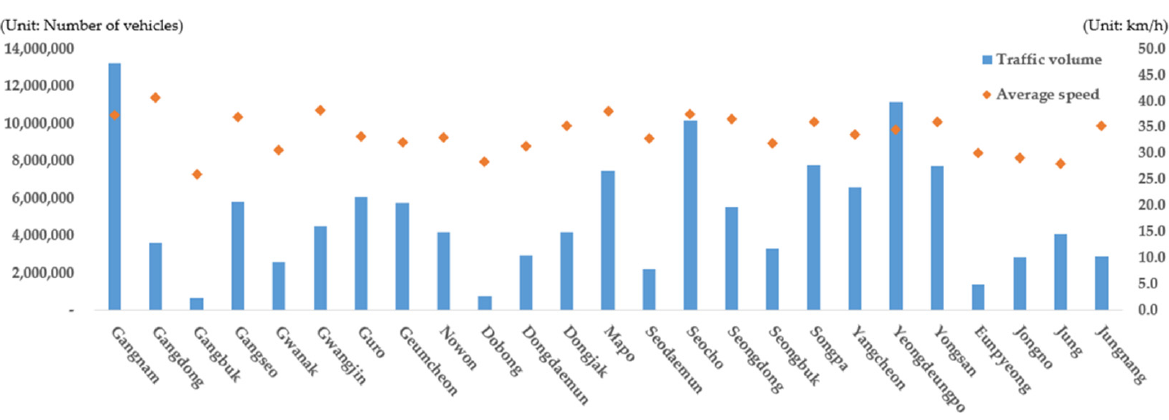
Figure 4. Seoul’s traffic volume and average speed by autonomous districts ( Gu ).